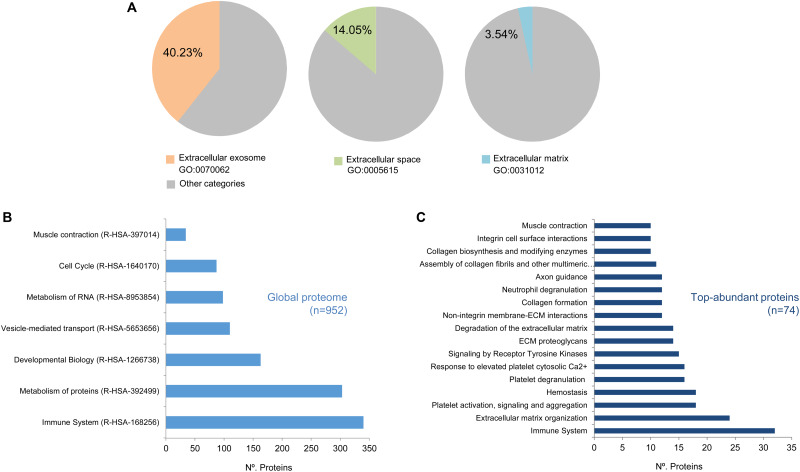
High-throughput proteomic analysis on EV-CDCs. Protein extracts from EV-CDCs (n = 4) and IFNγ/EV-CDCs (n = 4) were processed by high-resolution liquid chromatography coupled to tandem mass spectrometry analyses. Those proteins were identified by at least two peptides (n = 952) and were classified according to their biological function using annotations from the Gene Ontology (A) or Reactome (B,C) databases. (A) Pie charts representing the percentage of proteins (% of total pig annotated proteins) classified as Extracellular exosome (GO:0070062, orange), Extracellular space (GO:0005615, green), and Extracellular matrix (GO:0031012, blue) proteins. Significantly enriched Reactome top-level pathways [enrichment value of p < 0.01, 5% false discovery rate (FDR)] including (B) the global EV-CDC proteome (n = 952, Np ≥ 2) and (C) particular most abundant proteins (n = 74, Np ≥ 20).